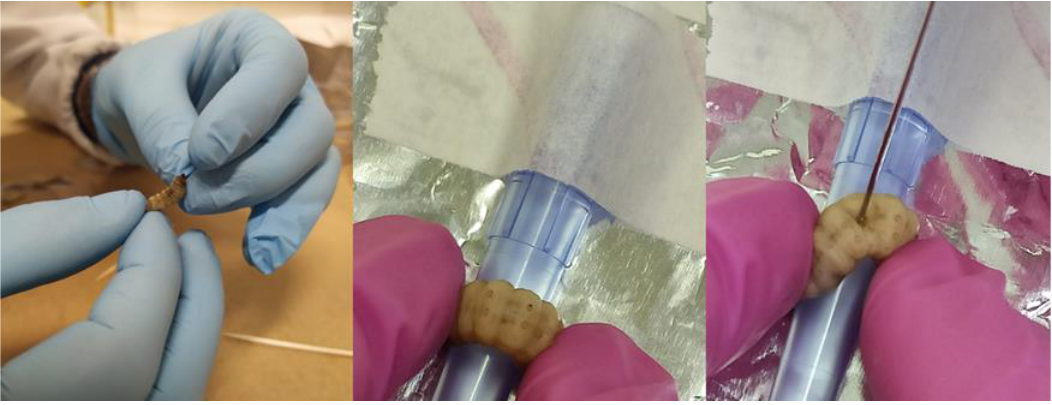
Figure 4. The sample application process in Galleria mellonella larvae.